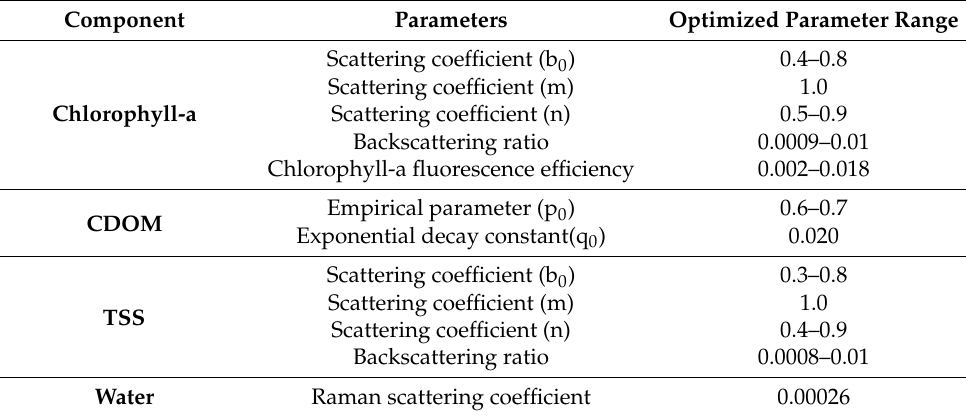
Table 3. Calibrated parameters for estimating reflectance